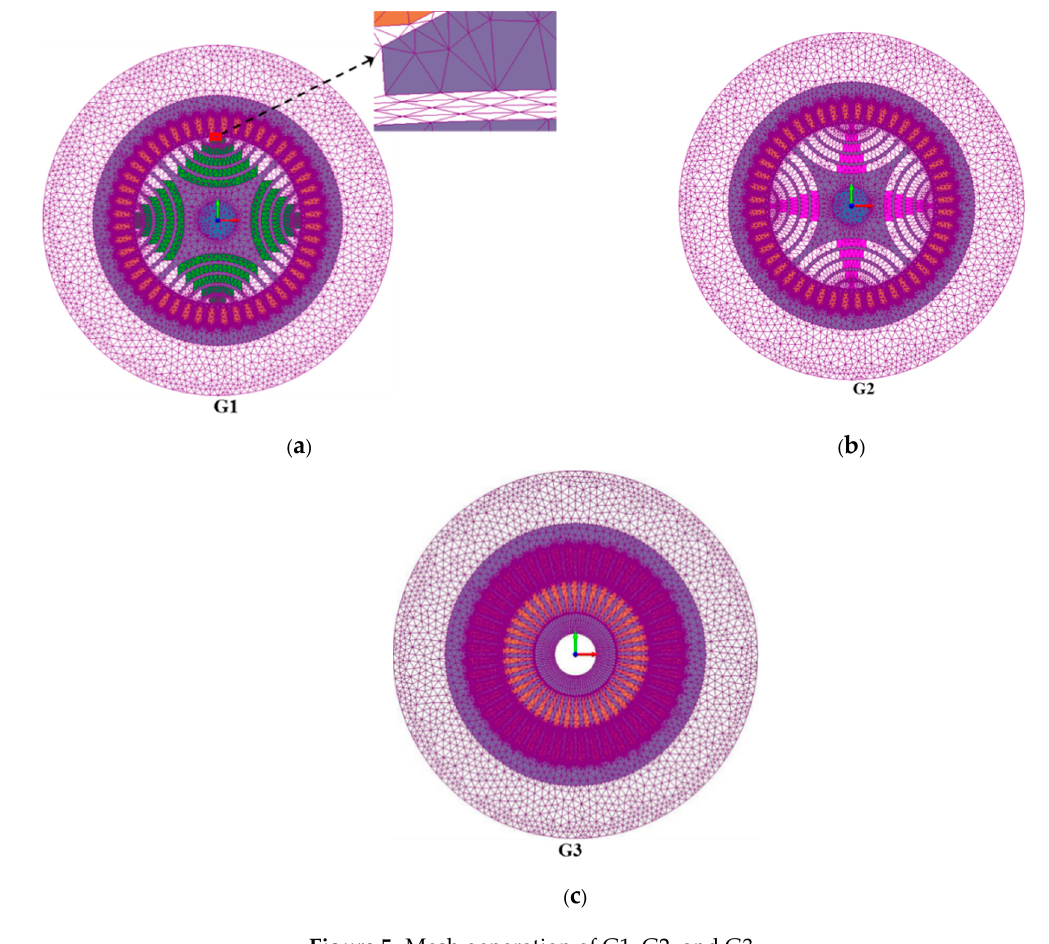
Figure 5. Mesh generation of G1, G2, and G3.